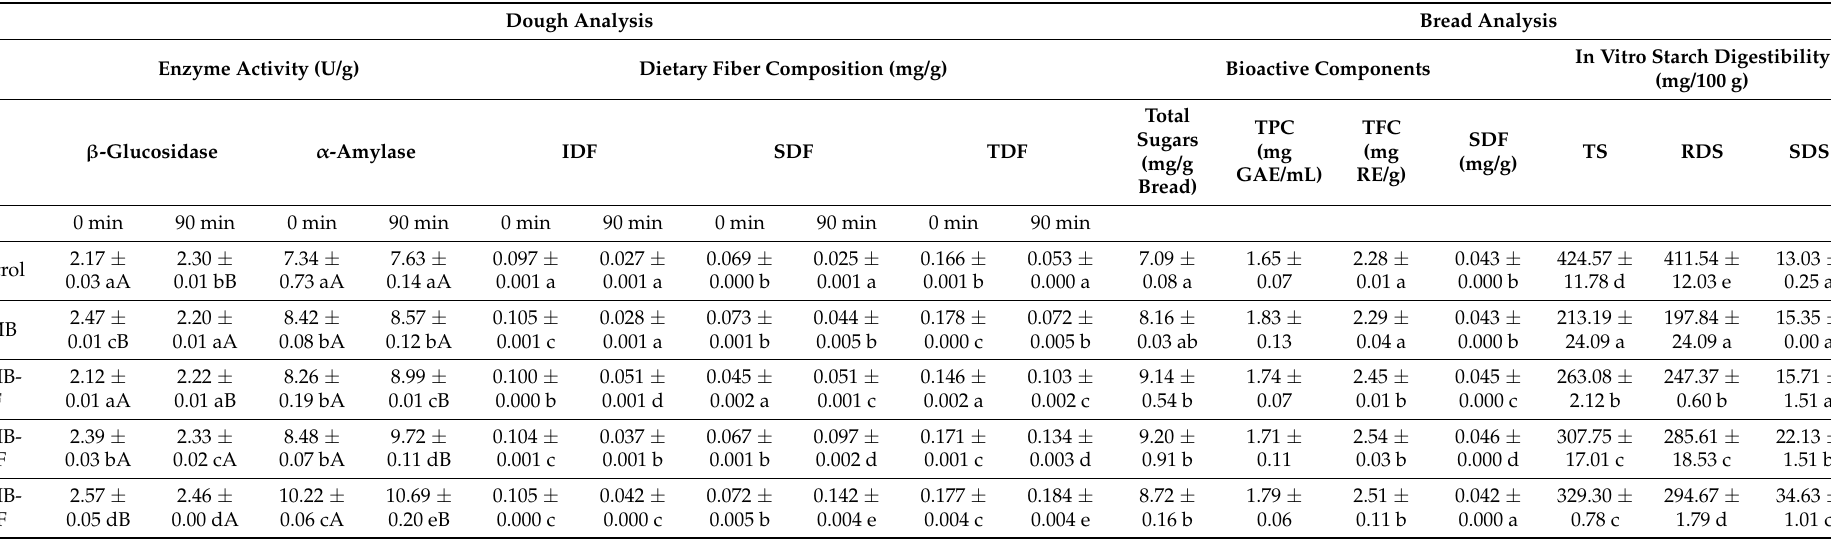
Table 2. Effect of pitaya fermentate supplementation on enzyme activities, the dietary fiber composition of dough, bioactive components, and starch digestibility of bread. Dough Analysis Bread Analysis Enzyme Activity (U/g) Dietary Fiber Composition (mg/g) Bioactive